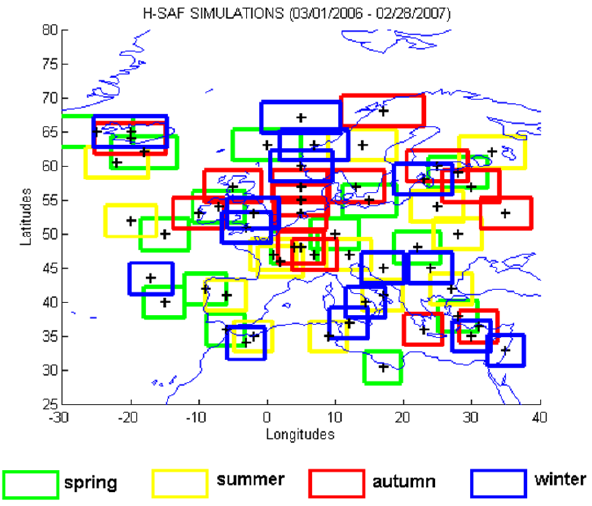
Figure 1. Inner domains of the 60 NMS simulations, divided by